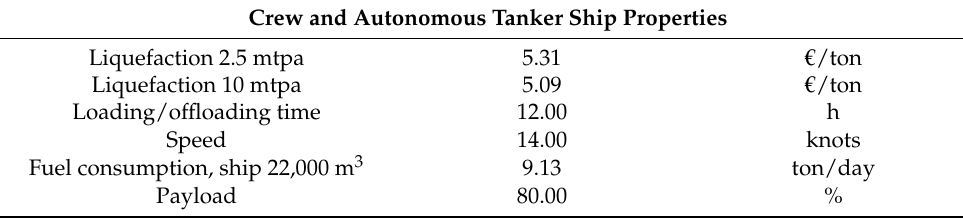
Table 10. Properties of the autonomous and crewed